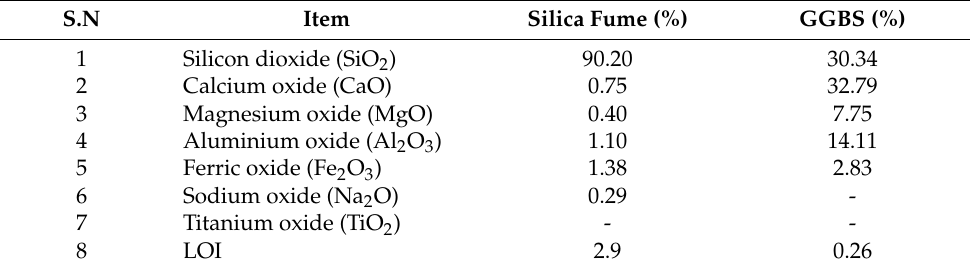
Table 1. Chemical composition of silica fume and GGBS.